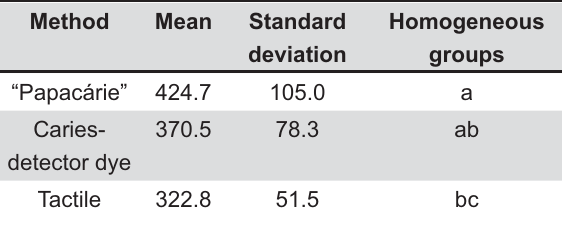
The groups followed by the same letters do not show Table 2- (cid:9)(cid:29)(cid:7)(cid:22)(cid:25)(cid:8)(cid:9)(cid:17)(cid:6)(cid:22)(cid:25)(cid:16)(cid:22)(cid:19)(cid:16)(cid:9)(cid:16)(cid:7)(cid:30)(cid:5)(cid:22)(cid:6)(cid:5)(cid:15)(cid:25)(cid:9)(cid:22)(cid:25)(cid:16)(cid:9)(cid:31)(cid:11)!(cid:7)(cid:24)"(cid:17)(cid:9)(cid:6)(cid:7)(cid:17)(cid:6)(cid:9)$%&’(cid:9)*(cid:15)(cid:19)(cid:9)(cid:16)(cid:7)(cid:25)(cid:6)(cid:5)(cid:25)(cid:7)(cid:9)/(cid:5)(cid:21)(cid:19)(cid:15)(cid:4)(cid:22)(cid:19)(cid:16)(cid:25)(cid:7)(cid:17)(cid:17)(cid:9)$(cid:5)(cid:25)(cid:9)<=’